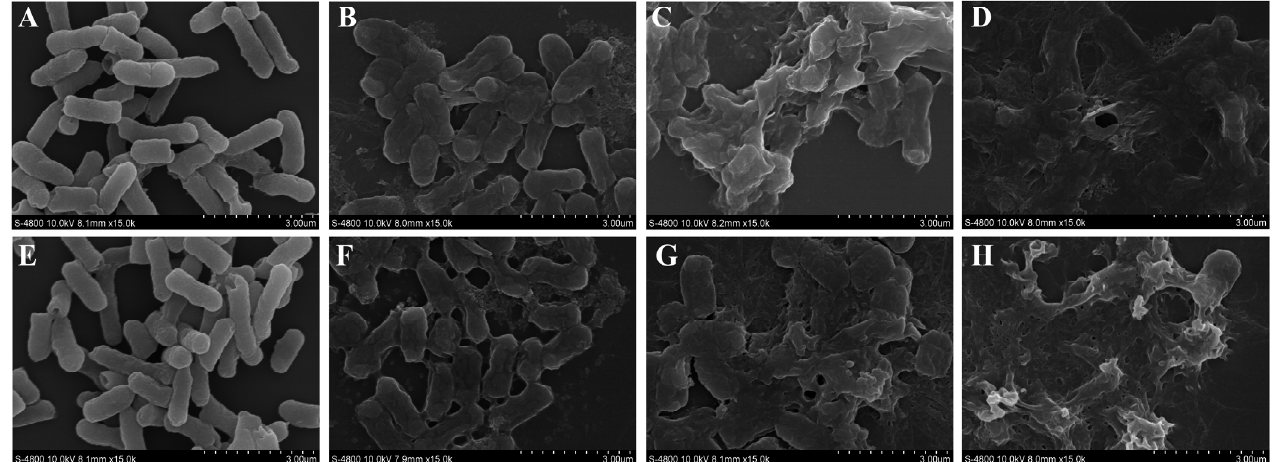
Figure 6. Field-emission scanning electron micrographs of S. sonnei . ( A ) Untreated bacterial cells at 2 h post-inoculation. ( B ) Bacterial cells treated with linalool at 1/2× MIC for 2 h. ( C ) Bacterial cells treated with linalool at 1× MIC for 2 h. ( D ) Bacterial cells treated with linalool at 3/2× MIC for 2 h. ( E ) Untreated bacterial cells at 4 h post-inoculation. ( F ) Bacterial cells treated with linalool at 1/2× MIC for 4 h. ( G ) Bacterial cells treated with linalool at 1× MIC for 4 h. ( H ) Bacterial cells treated with linalool at 3/2× MIC for 4 h.